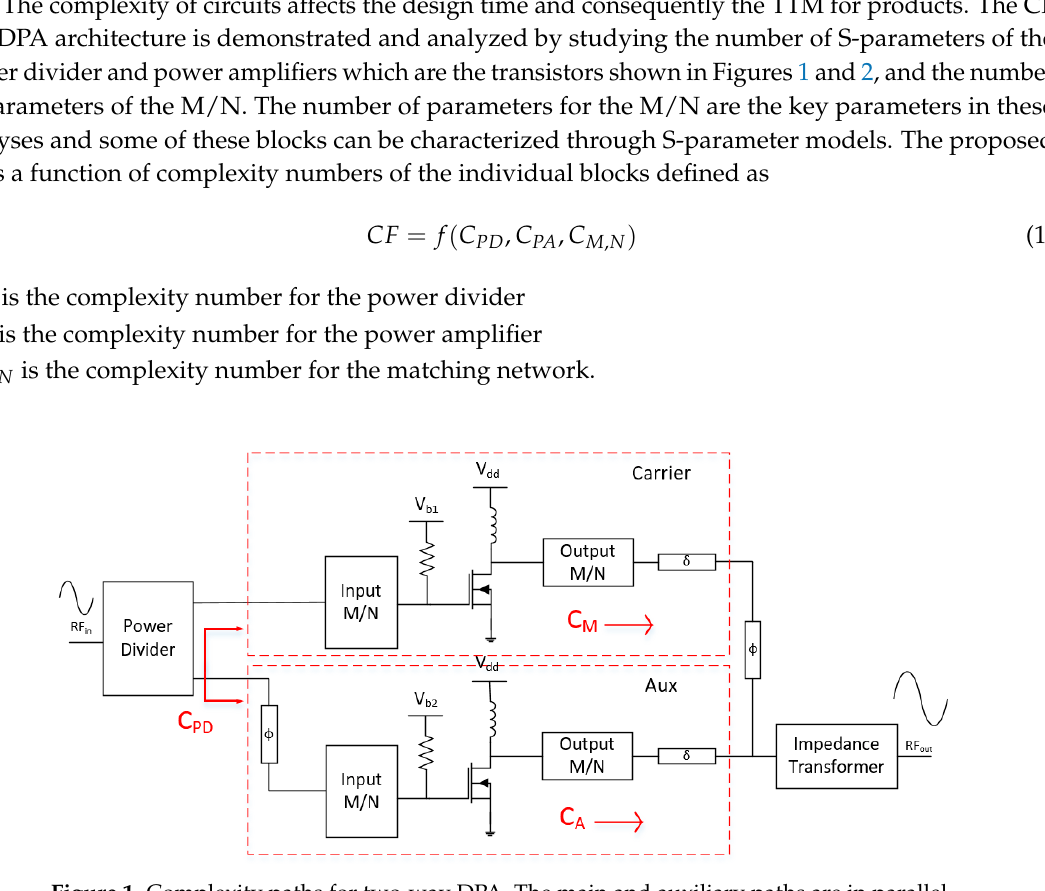
Figure 2. Complexity paths for three ‐ way DPA. The main and two auxiliary paths are in parallel. This could be done by tuning the variables with computer aided design (CAD) tools. The paths for analyses are shown with the individual branches in series while the power divider is a parallel block. The following sections briefly introduce the individual blocks and the simplified models used for the complexity analysis. 3. Proposed Complexity Factor For DPA For a design with higher complexity, a deduction can be made that the optimization time will be longer whether done manually or by an optimization software. Consider a two ‐ way conventional DPA, it is observed that it could be broken down into three sub ‐ blocks which are the power divider, the main and auxiliary PA branches. As the power divider and the PAs can be designed as standalones before the integration, complexities with their S ‐ Parameters can be quantified. For a two ‐ way DPA, two output and one input ports are utilized for the power divider. Extending to a three ‐ way DPA, three output and one input ports will be used. A conventional two ‐ port PA would have four S ‐ parameters and an equation can be derived to extend to multi ‐ port PA (MPA). Therefore, the complexity numbers for the power divider and PA are 𝐶 (cid:3017)(cid:3005) (cid:3404) (cid:4666)𝑛 (cid:3397) 1(cid:4667) (cid:2870)